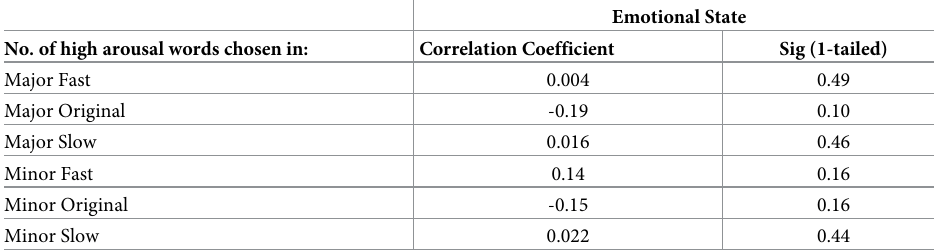
Table 2. Spearman’s correlation coefficients of emotional state and high arousal words